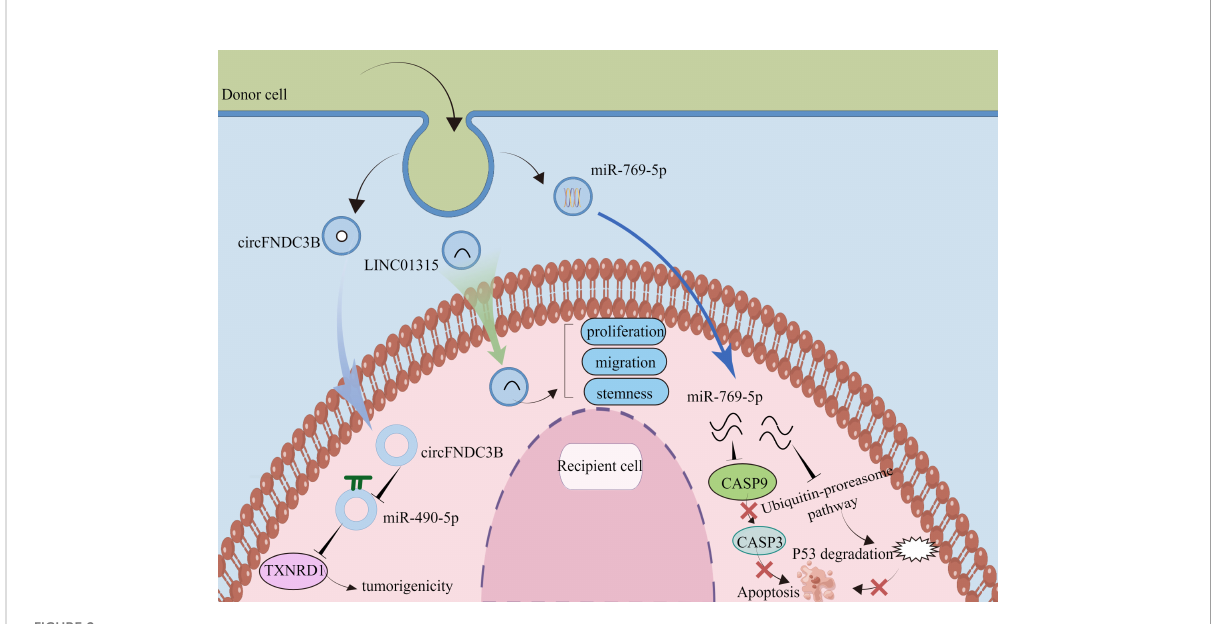
FIGURE 2 Tumor-derived exosomal ncRNAs function. (By